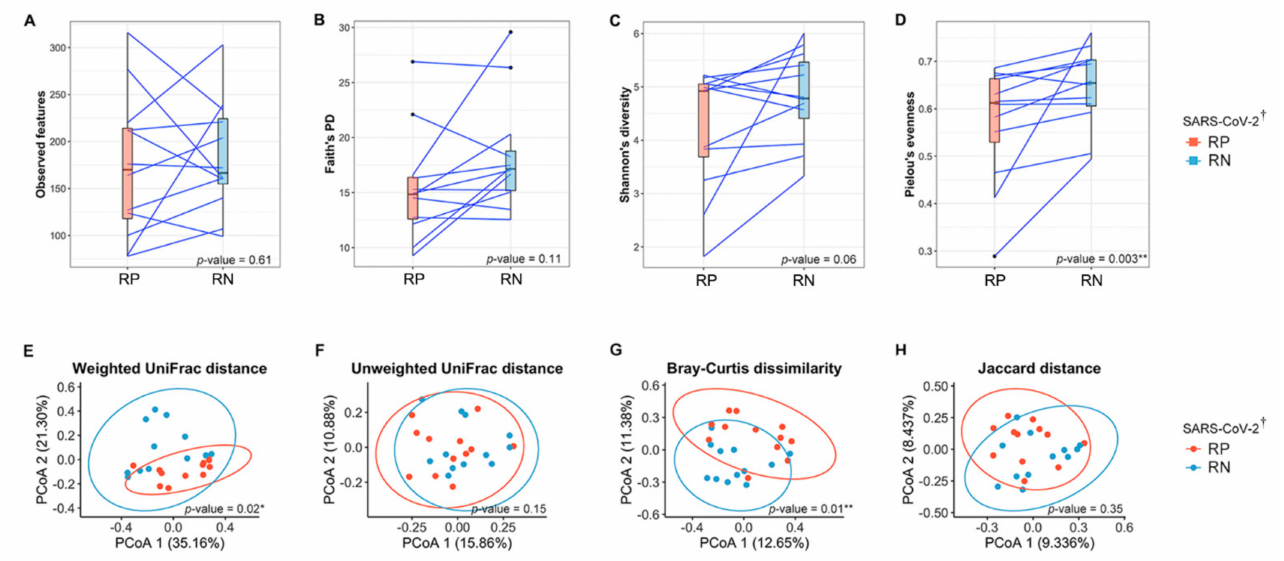
Figure 2. Comparison of the gut microbial diversity between infected (respiratory positive (RP)-SARS-CoV-2) and recovered (respiratory negative (RN)-SARS-CoV-2) states of patients with COVID-19. ( A ) Observed features, ( B ) Faith’s phylogenetic diversity, ( C ) Shannon’s index, and ( D ) Pielou’s evenness were alpha diversity in the paired samples. Blue lines connect pairwise samples of infected and recovered states in same patients. The box plots indicate the interquartile range (IQR). The IQR is the 25th to 75th percentile. The median value is shown as a line within the box. The p -values were calculated using Wilcoxon signed-rank exact test. ( E – H ) PCoA plots of beta diversity of infected state and recovered state of 12 patients diagnosed with SARS-CoV-2. Overall gut microbial community of patients as represented by PCoA of phylogenetic and non-phylogenetic measurements. ( E ) Weighted UniFrac distance. ( F ) Unweighted UniFrac distance. ( G ) Bray–Curtis dissimilarity. ( H ) Jaccard distance. Each point represents a single sample with ellipses for the 95% confidence interval for each state of COVID-19. The p -values were calculated using pairwise permutational multivariate analysis of variance (PERMANOVA) test with 999 random permutations. * p < 0.05, ** p < 0.01. † SARS-CoV-2 RNA from the respiratory tract. RP, respiratory positive SARS-CoV-2; RN, respiratory negative